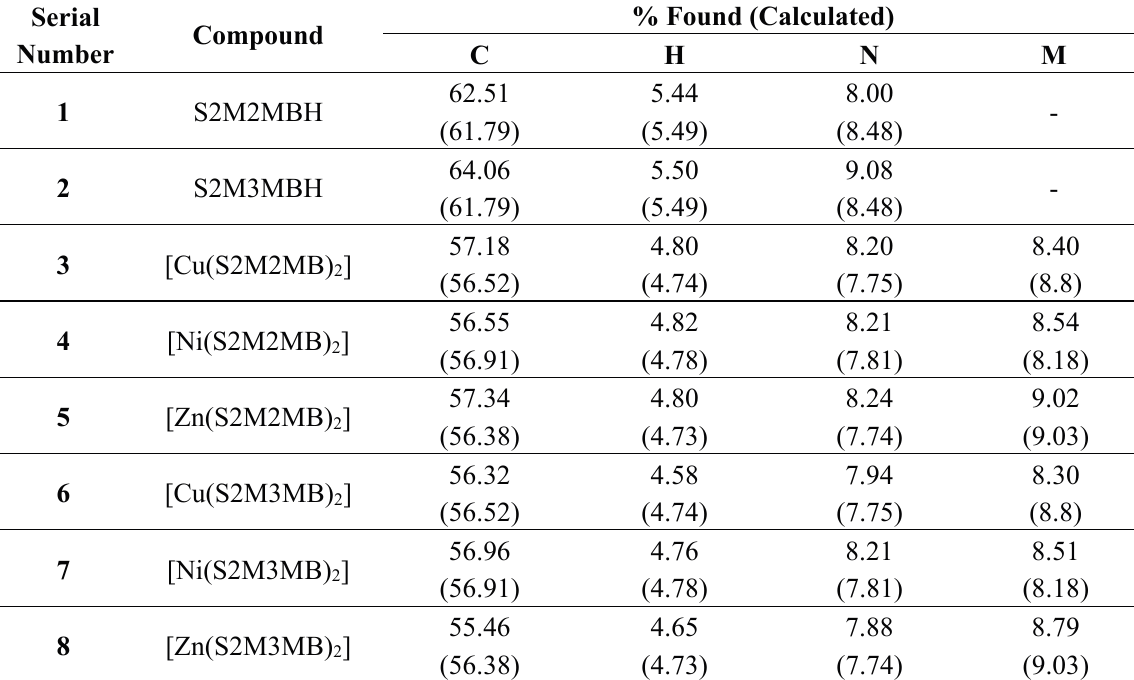
Table 1. Analytical data of the Schiff bases and their metal